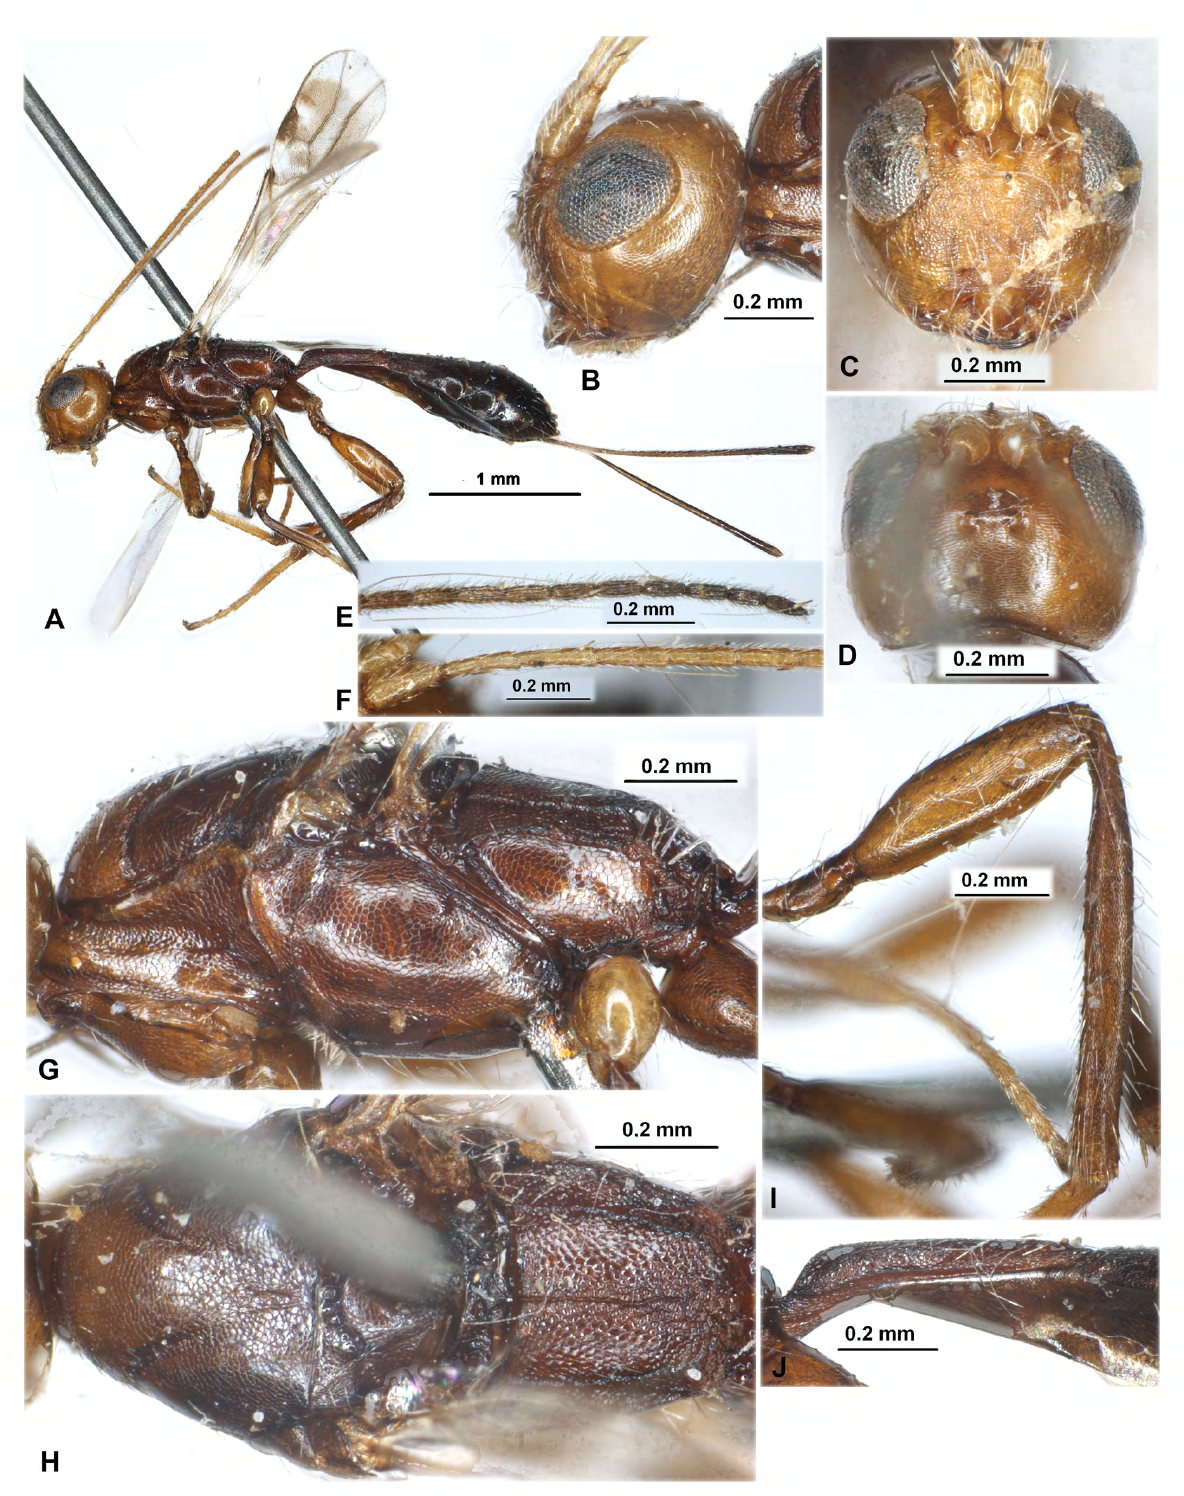
Fig. 30. Platyspathius ( Platyspathius ) venezuelicus sp. nov., ♀, holotype, IB-UNAM. A . Habitus, lateral view. B . Head, front view. C . Head, dorsal view. D . Head, lateral view. E . Basal segments of antenna. F . Mesosoma, dorsal view. G . Mesosoma, lateral view. H . Propodeum and first metasomal tergite, dorsal view. I . First metasomal tergite, lateral